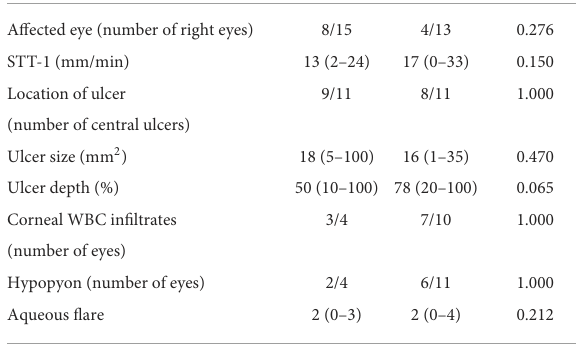
Results are presented as median (range) for numerical data and proportion of dogs for categorical data, comparing dogs with MDR vs. non-MDR bacterial keratitis